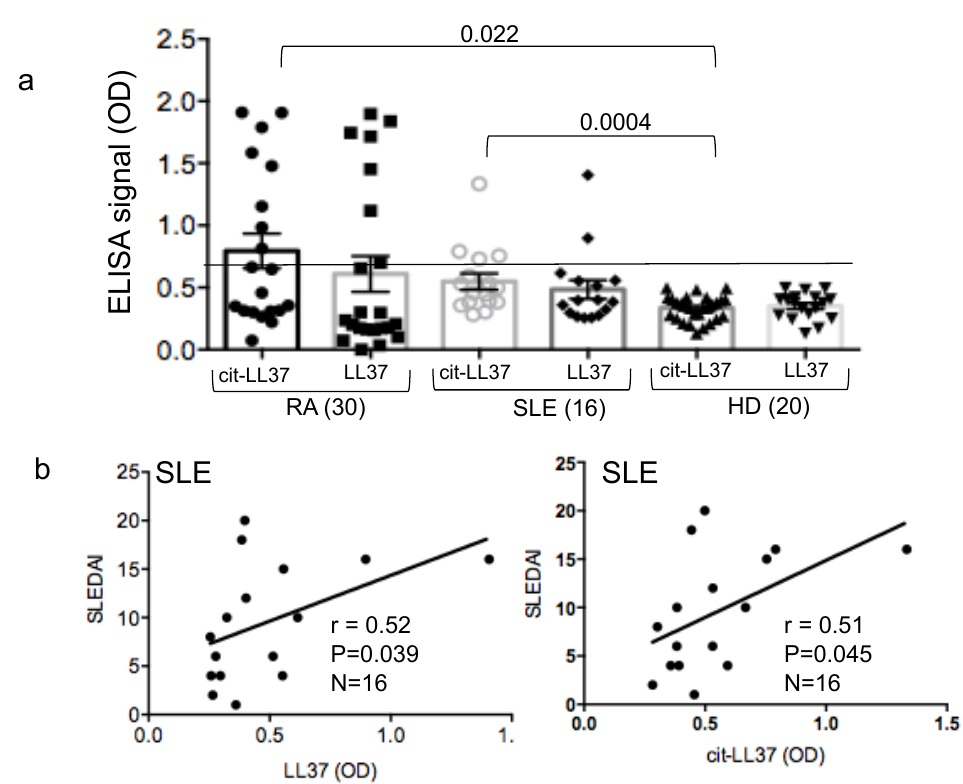
Figure 9. Native LL37 and cit-LL37 are present in circulation of RA and SLE patients. ( a ) RA and SLE sera were diluted 1–100 in ELISA plates coated with MRB139 or MRB142 (1:50) and ELISA was performer as in Material and Methods. Horizontal bars are the means; vertical bars are standard errors of the mean, p values calculated by Mann-Whitney test. Sample size indicated in brackets. The horizontal line indicates cut-o ff determined by reactivity of HD, as explained in Material and Methods. ( b ) Correlation by Spearman’s correlation test (two-tailed) between presence of native